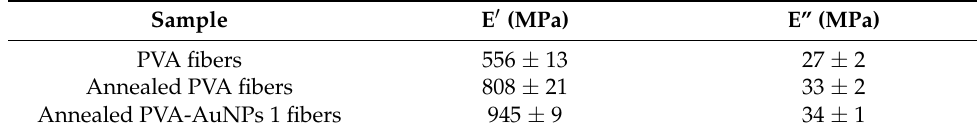
Table 4. Dynamic-mechanical properties of as-prepared PVA fibers, annealed PVA fibers, and annealed PVA-AuNPs 1 fibers. Moduli values have been taken at a frequency of 1 Hz.